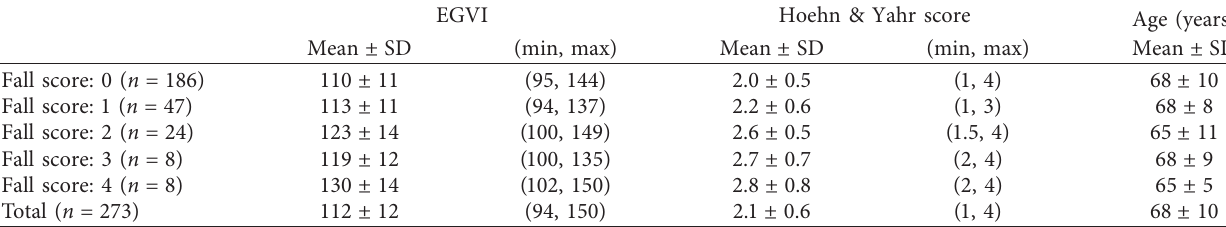
Table 2: Clinical and demographic metrics across fall frequency groups.